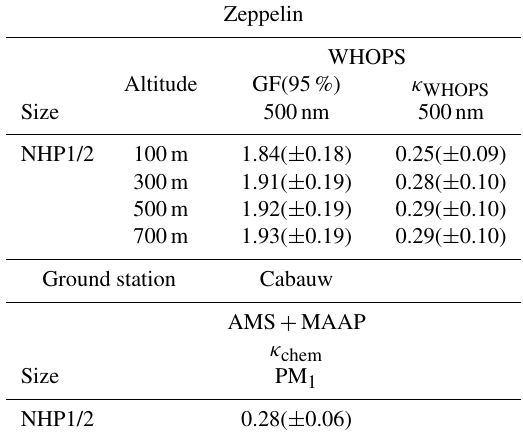
Table 3. Mean GF and κ values for NHP1/2 with respective accura- cies are presented. For the WHOPS measurements at four different altitudes are shown. κ chem is calculated from the Cabauw ground site combining AMS and MAAP